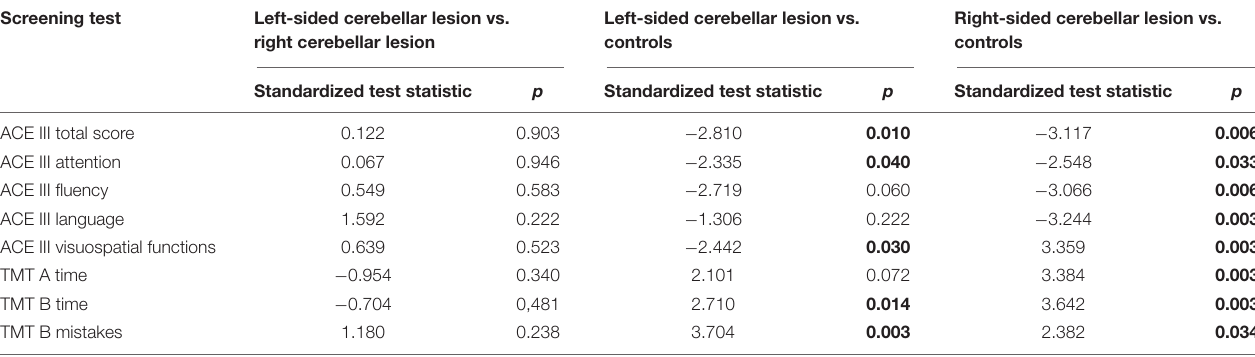
Screening test Left-sided cerebellar lesion vs.